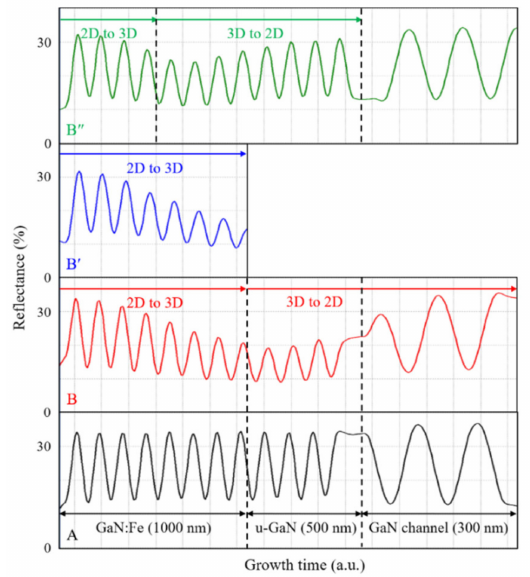
Figure 2. In situ reflectance monitoring on the surfaces of Samples A, B, B (cid:48) , and B (cid:48)(cid:48)